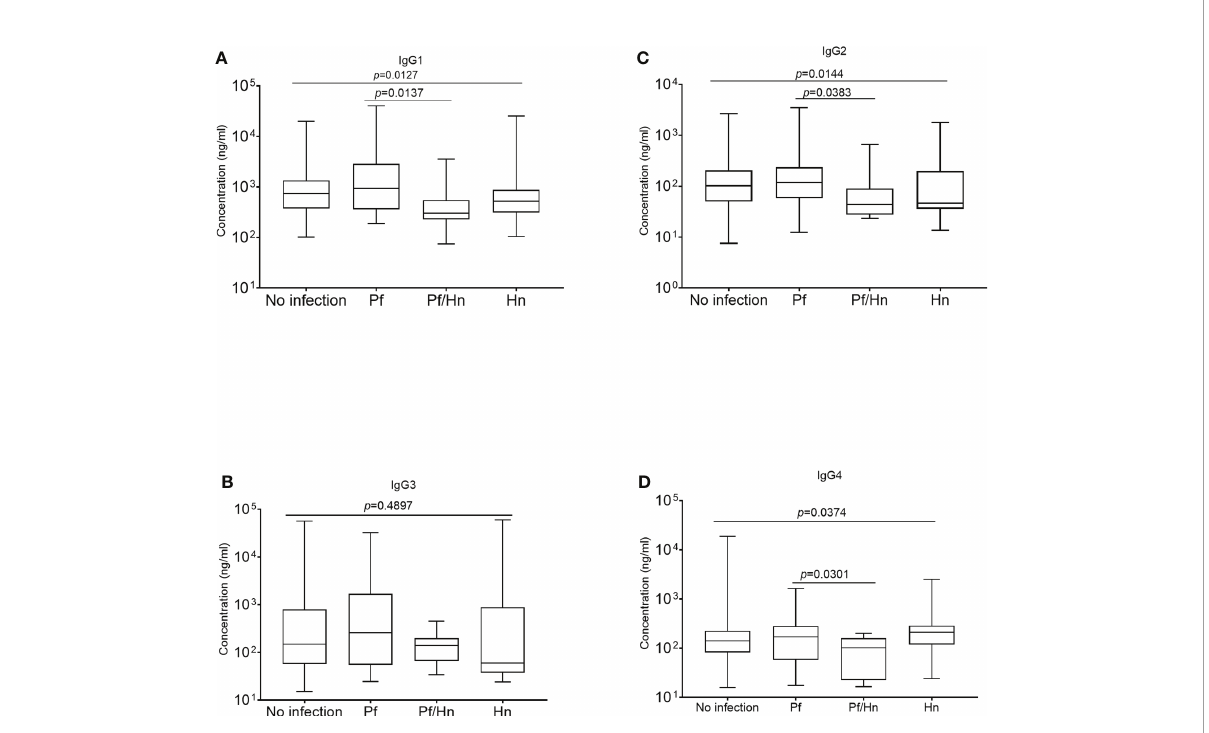
FIGURE 4 Hymenolepis nana infection associated with reduced plasma levels of GMZ2-speci fi c IgG subclasses. The median values are plotted as box plots with the edges corresponding to the interquartile range. The lower whisker of each box indicates the minimum value, while the upper whisker corresponds to the highest antibody value. Levels of IgG1, IgG2, IgG3 and IgG4 in the various groups areare displayed in plots (A – D) , respectively.